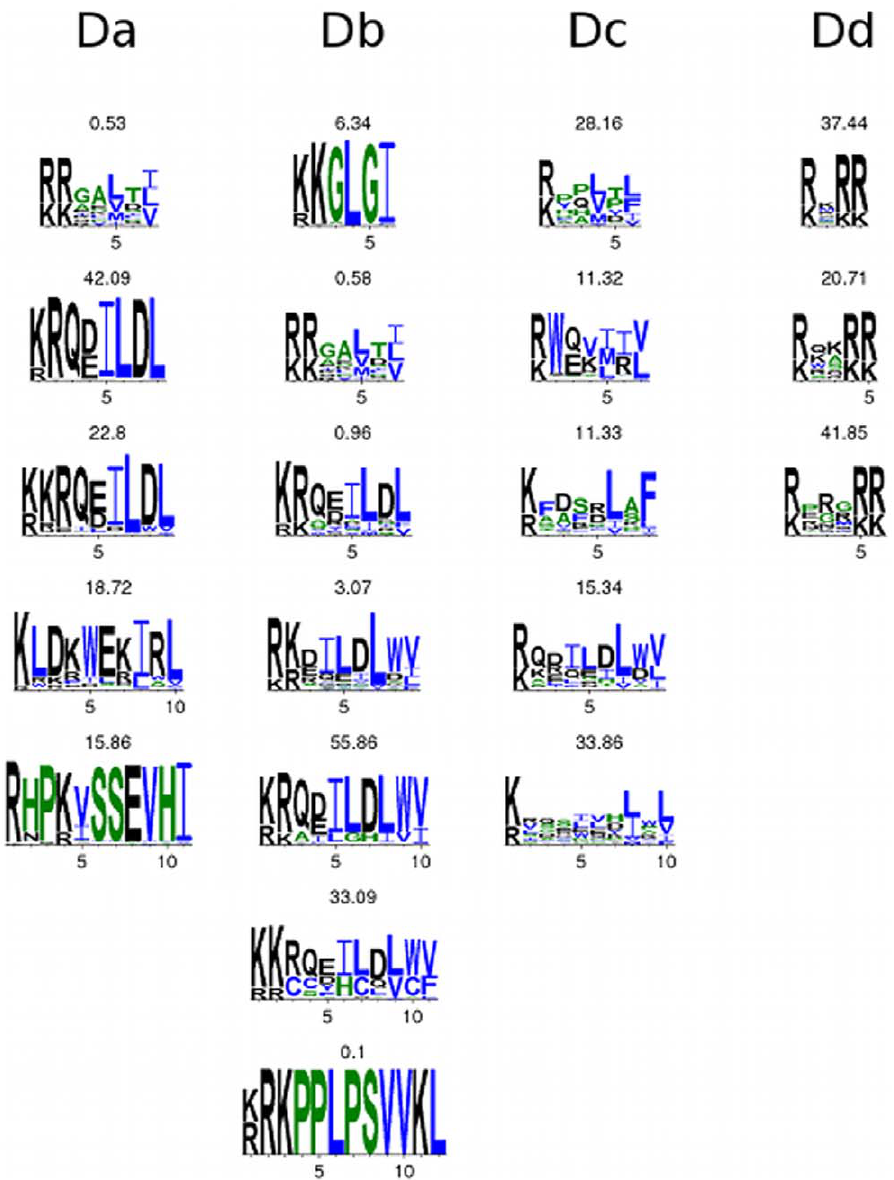
Figure 3. HIV Sequence logos. For each MAPK docking site motif, we gathered all hits on all HIV proteins and constructed sequence logos for hits with the same length. The percentage of motif instances of a certain length is shown above each logo.